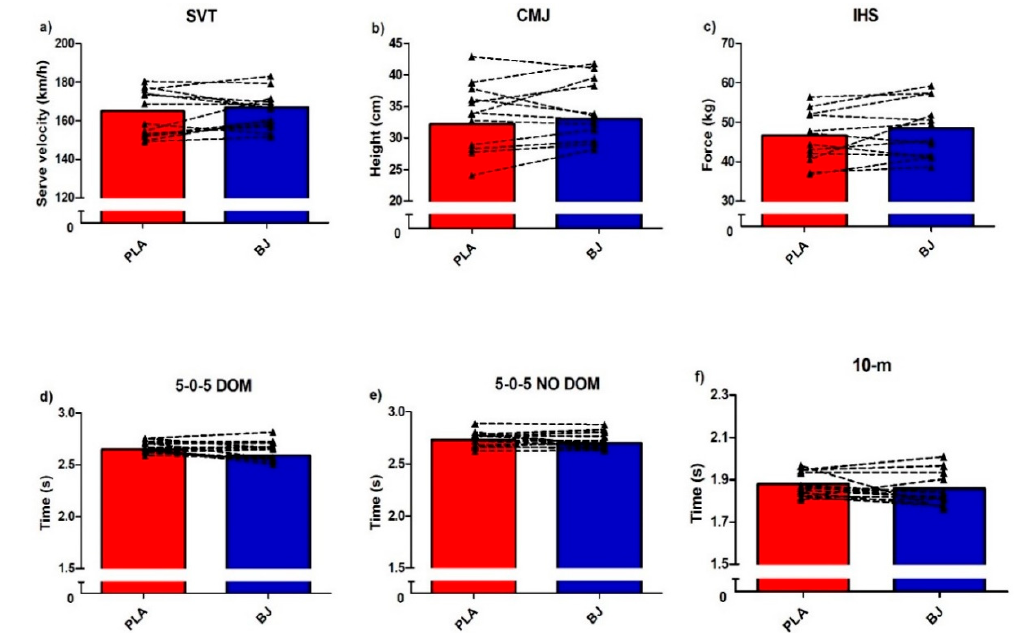
Figure 2. Effects of beetroot juice (BJ) or placebo (PLA) on ( a ) SVA: serve velocity test; ( b ) CMJ: countermovement vertical jump height; ( c ) IHS: isometric handgrip strength; ( d ) 5-0-5 DOM: agility test dominant side; ( e ) 5-0-5 NO-DOM: agility test nondominant side; ( f ) 10-m: 10 m sprint.